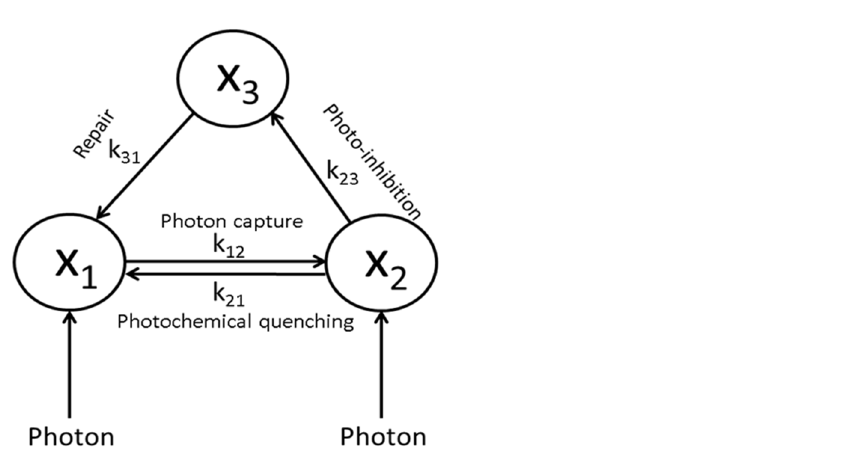
Figure 4. Schematic diagram showing the three states of the dynamic growth model for microalgal cells according to Eilers and Peeters (1988) [38].